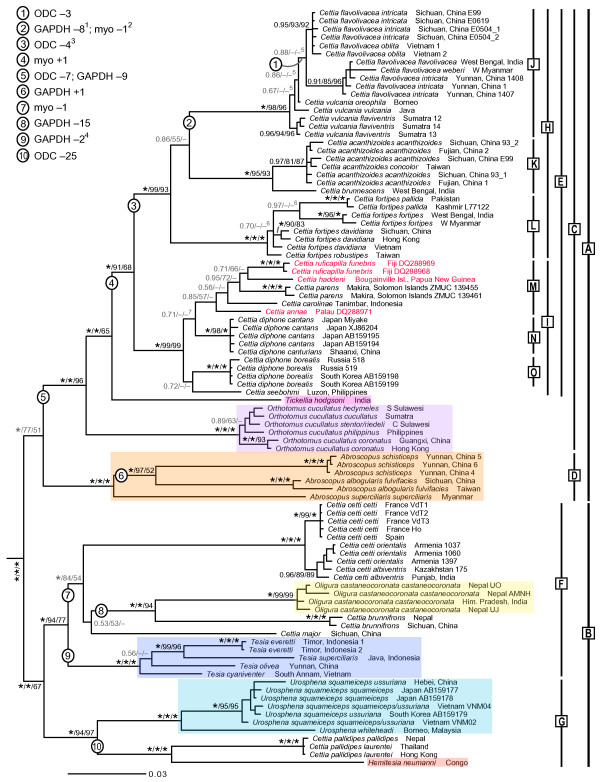
Tree of Cettiidae based on concatenated sequences - all taxa, partitioned analysis. Majority rule (50%) consensus tree, based on concatenated nuclear ODC, myoglobin and GAPDH and mitochondrial cytochrome b, inferred by Bayesian inference (BI), analysed in four partitions. All available sequences (including all subspecies) were included. Generic affinity according to traditional taxonomy [12] is indicated by different colour shadings. Labelled bars denote clades discussed in text. The three species for which only cytochrome b is available are in red. Posterior probabilities, and maximum likelihood (ML) and parsimony (MP) bootstrap values are indicated at the nodes, in this order; an asterisk represents posterior probability (PP) 1.00 or bootstrap 100%, and nodes with PP < 0.95 and/or conflicts between BI, ML and MP are in grey. The outgroups (Alauda arvensis and Mirafra javanica in Alaudidae and Orthotomus sepium, O. sutorius and Prinia familiaris in Cisticolidae) have been pruned from the tree. Numbers on internal branches refer to indels. 1Also in Cettia cetti and C. fortipes fortipes W Myanmar. 2Same position as number 4. 3Also in Tickellia hodgsoni. 4Also in Cettia major. 5According to MP, C. vulcania vulcania and C. vulcania oreophila form a trichotomy with C. flavolivacea intricata Sichuan/C. flavolivacea oblita (54%), and these are sisters to C. vulcania flaviventris (98%). 6According to MP, C. fortipes pallida is sister to the other C. fortipes subspecies (74%). According to ML, C. fortipes davidiana Vietnam and C. fortipes robustipes are sisters (62%), and these are sisters to C. fortipes davidiana Sichuan/Hong Kong (65%); according to MP, these relationships receive 71% and 100% support, respectively.